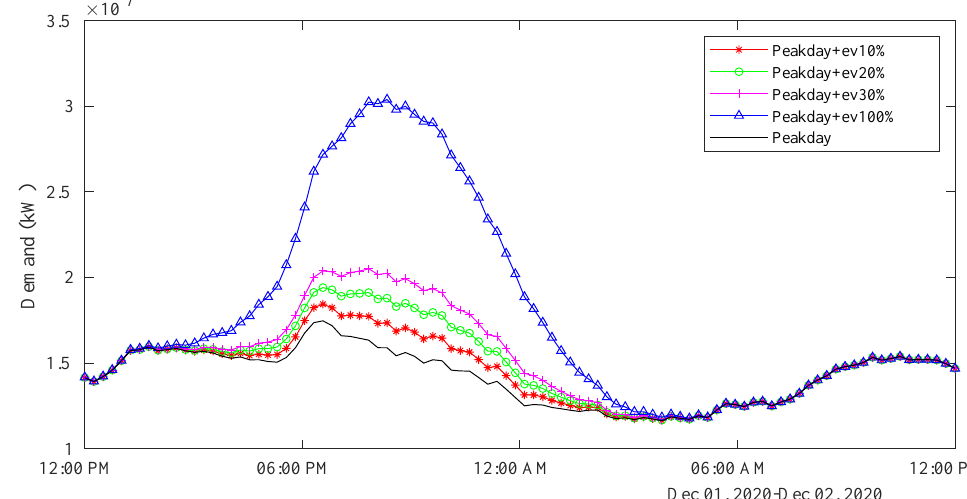
Figure 9. Load demand of the PEA when various levels of EV penetration are applied and uniform distribution of S i is considered.